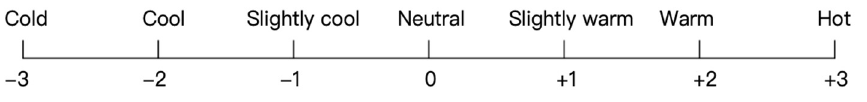
Figure 3. Thermal sensation 7-point scale of ASHARE.